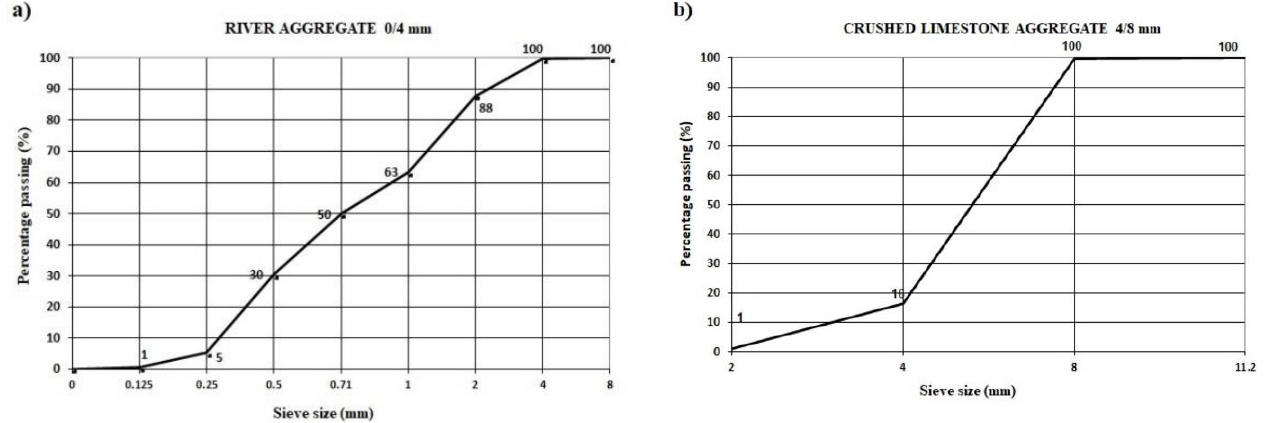
Figure 5. Particle size distribution of river aggregate 0/4 mm ( a ) and crushed limestone aggregate 4/8 mm ( b ).